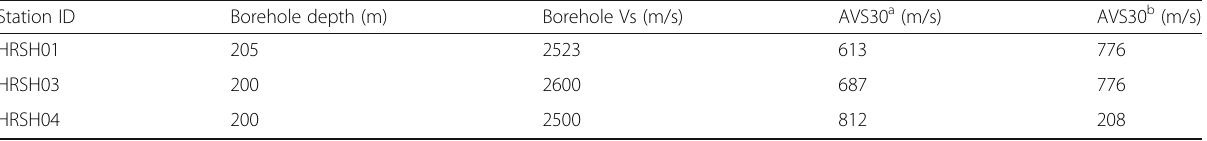
Table 2 List of the KiK-net stations used in this study Station ID Borehole depth